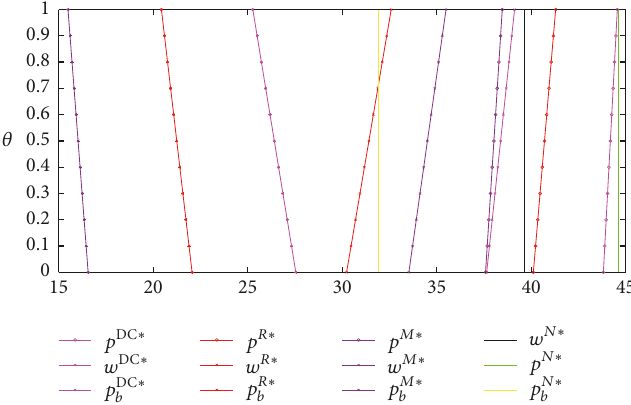
Figure 6: Effects of 𝜃 on the pricing strategies of supply chain members.